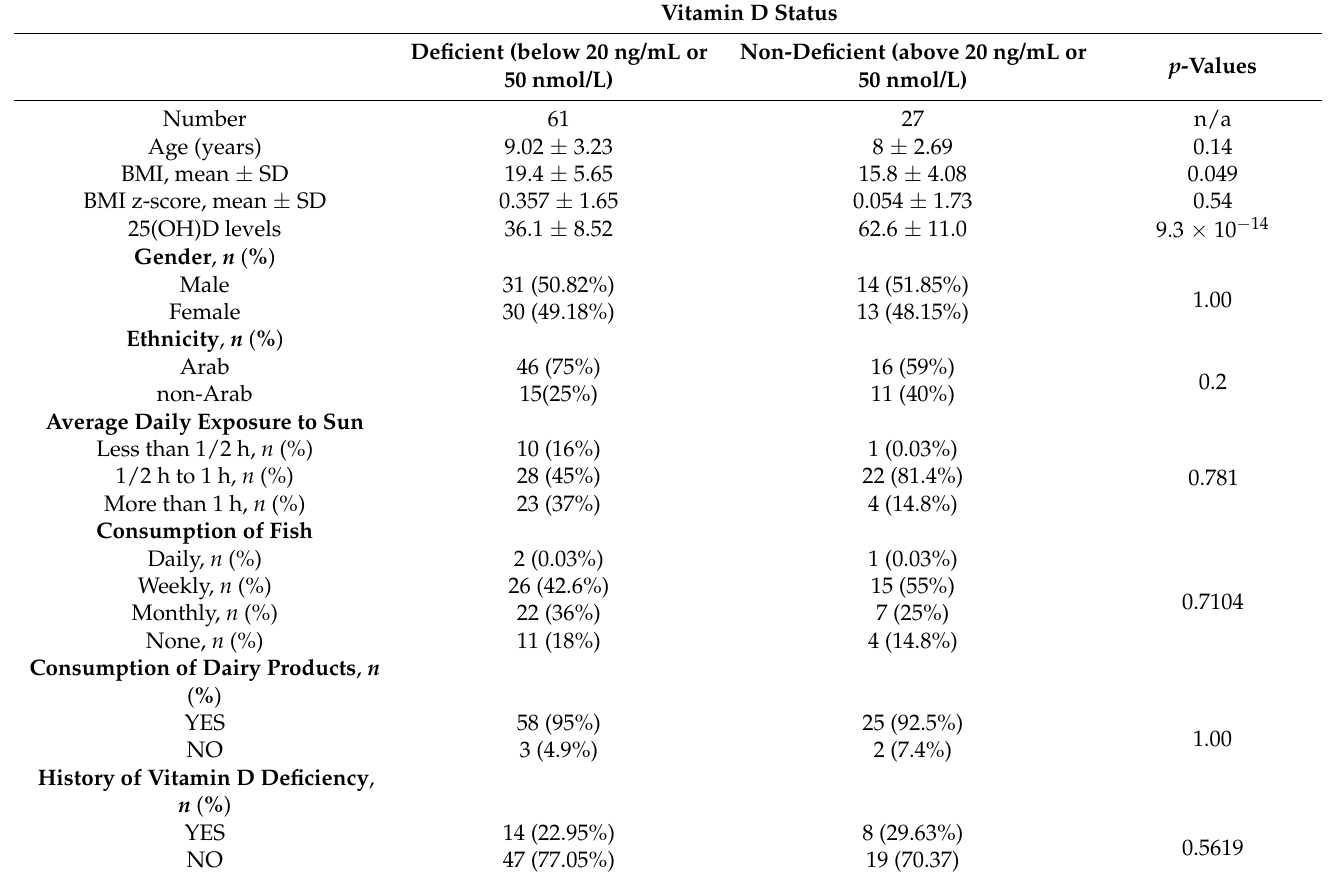
Table 1. Baseline characteristic of the study